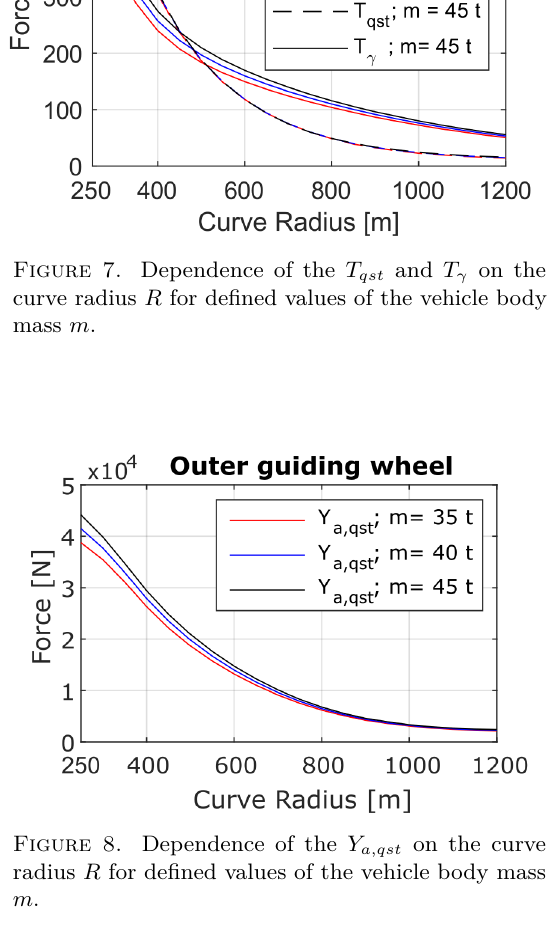
a,qst on the curve